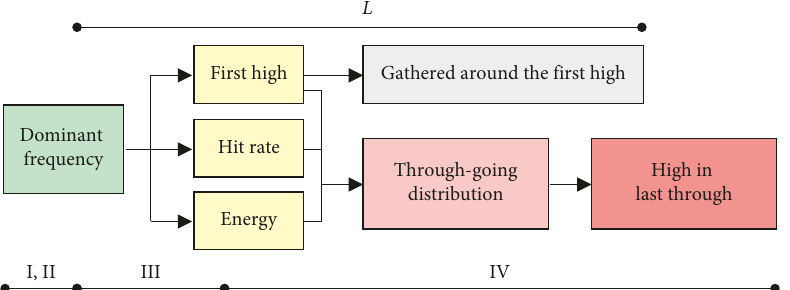
Figure 13: ThegeneralchronologicalorderoftheAEdataandthecorrespondingcrackdevelopmentstageandrockstability( representshighto medium stability; represents high stability; represents low stability; represents very low stability; represents the failure is approaching).